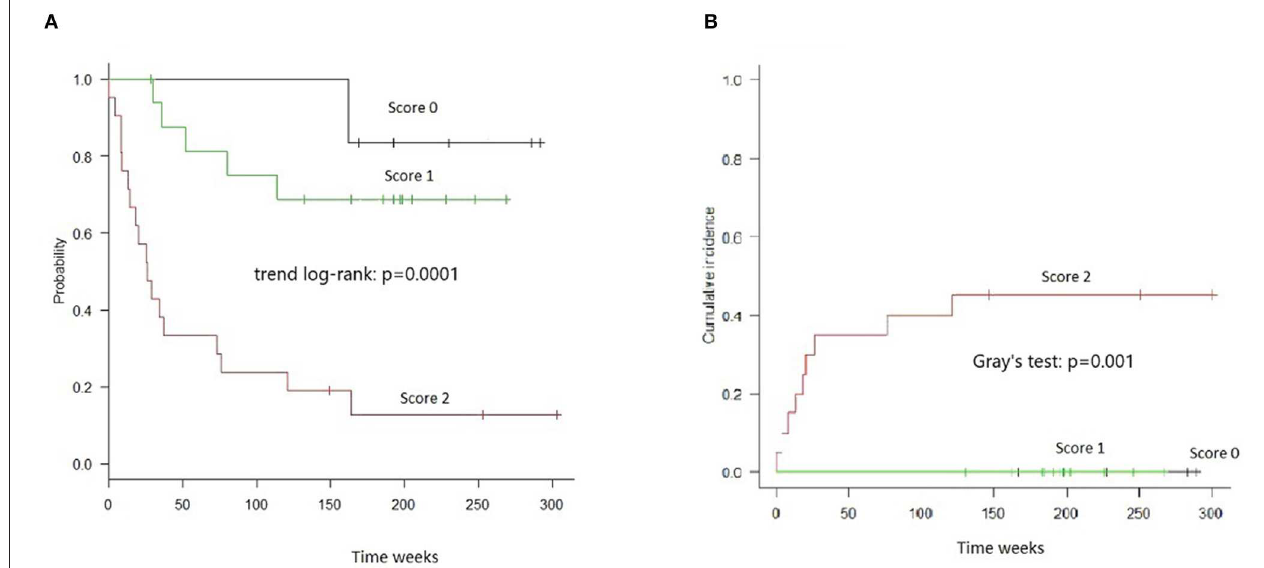
FIGURE 3 | OS and TRM in HAPLO-MUD transplants in groups of patients identified by combined cytokines score. (A) OS resulted significantly different (trend log-rank: p = 0.0001); score 2 patients had a median survival of 26 weeks. (B) TRM evaluated by Gray’s test resulted significantly different ( p =